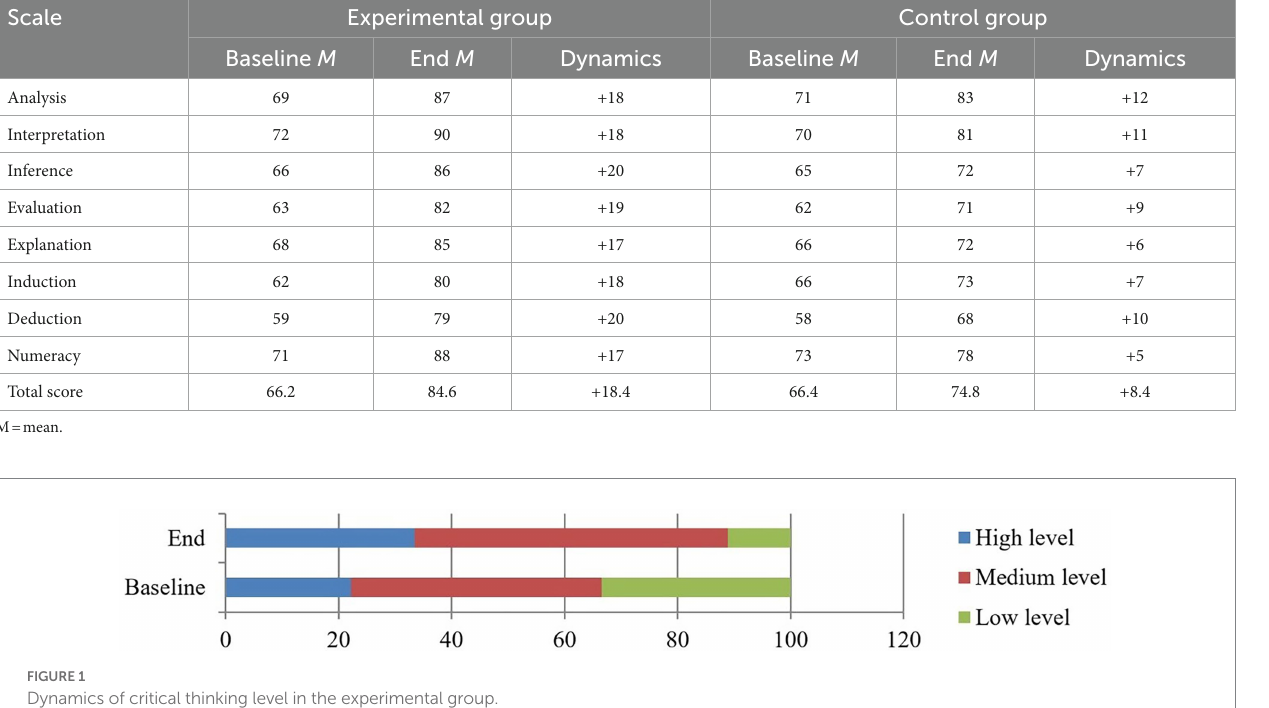
TABLE 2 Comparative table of mean students’ critical thinking levels at baseline and after the experiment.